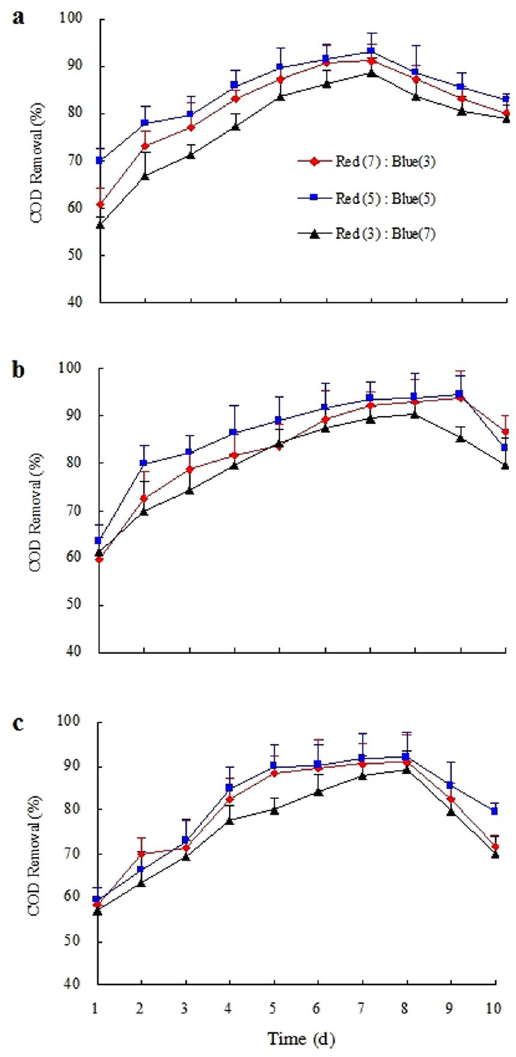
Figure 1. COD removal efficiency over time at cultures 2 under the mixed LED light wavelength treatments for the three selected microalgae species: ( a ) Chlorella vulgaris , ( b ) Scenedesmus obliquus , and ( c ) Nitzschia palea